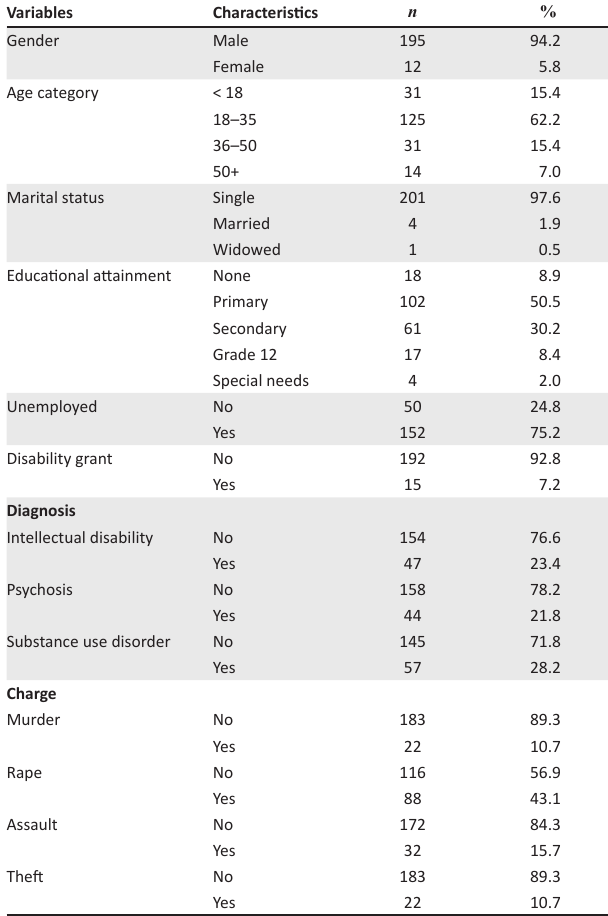
TABLE 1: Socio-demographic, clinical and forensic profiles of overall sample.